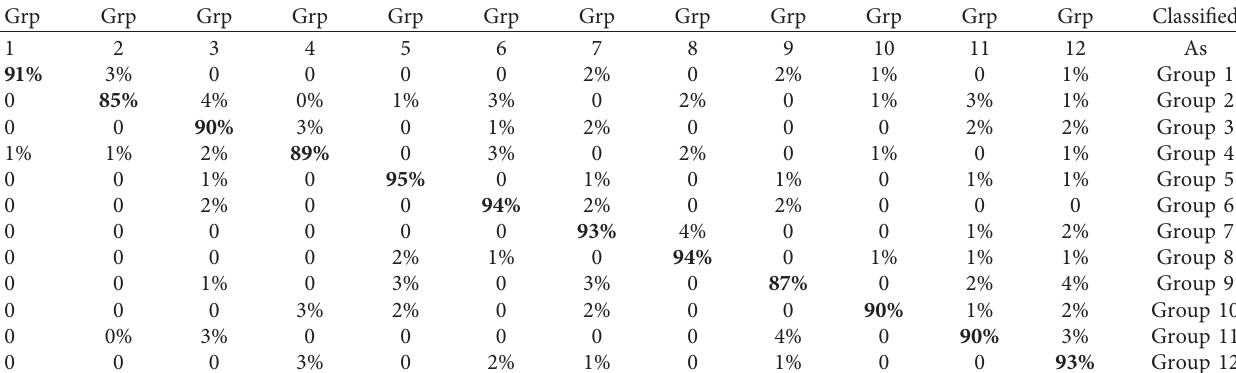
Table 4: The confusion matrix showing accuracy rate of classification of Urdu handwritten characters using 8-fold cross validation. Grp Grp